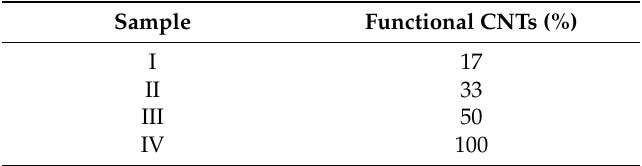
Table 1. List of synthesized % functional carbon nanotubes (CNT)